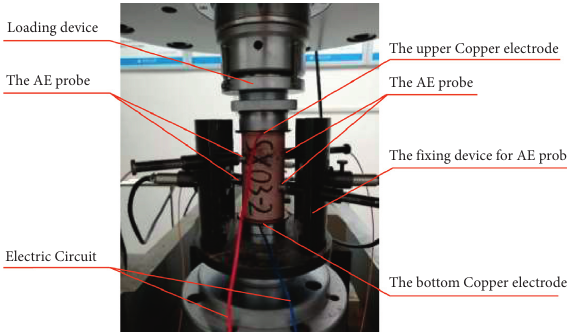
Figure 2: Stress-AE-resistivity synchronous testing device.